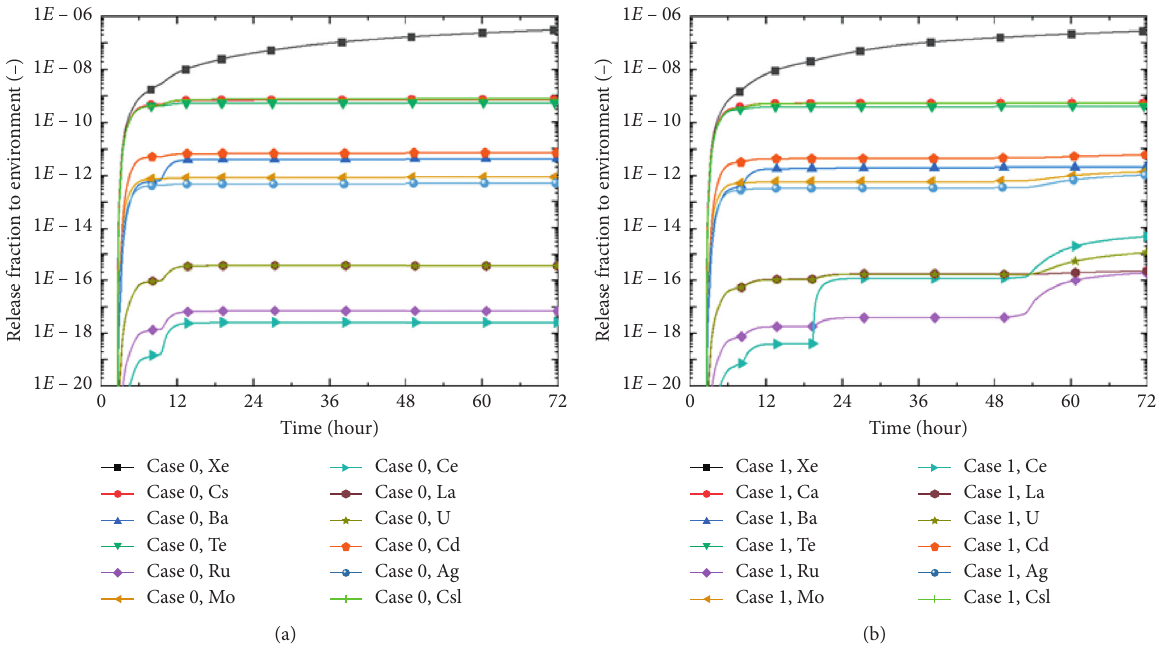
Figure 7: Release fraction to the environment: (a) case 0 and (b) case